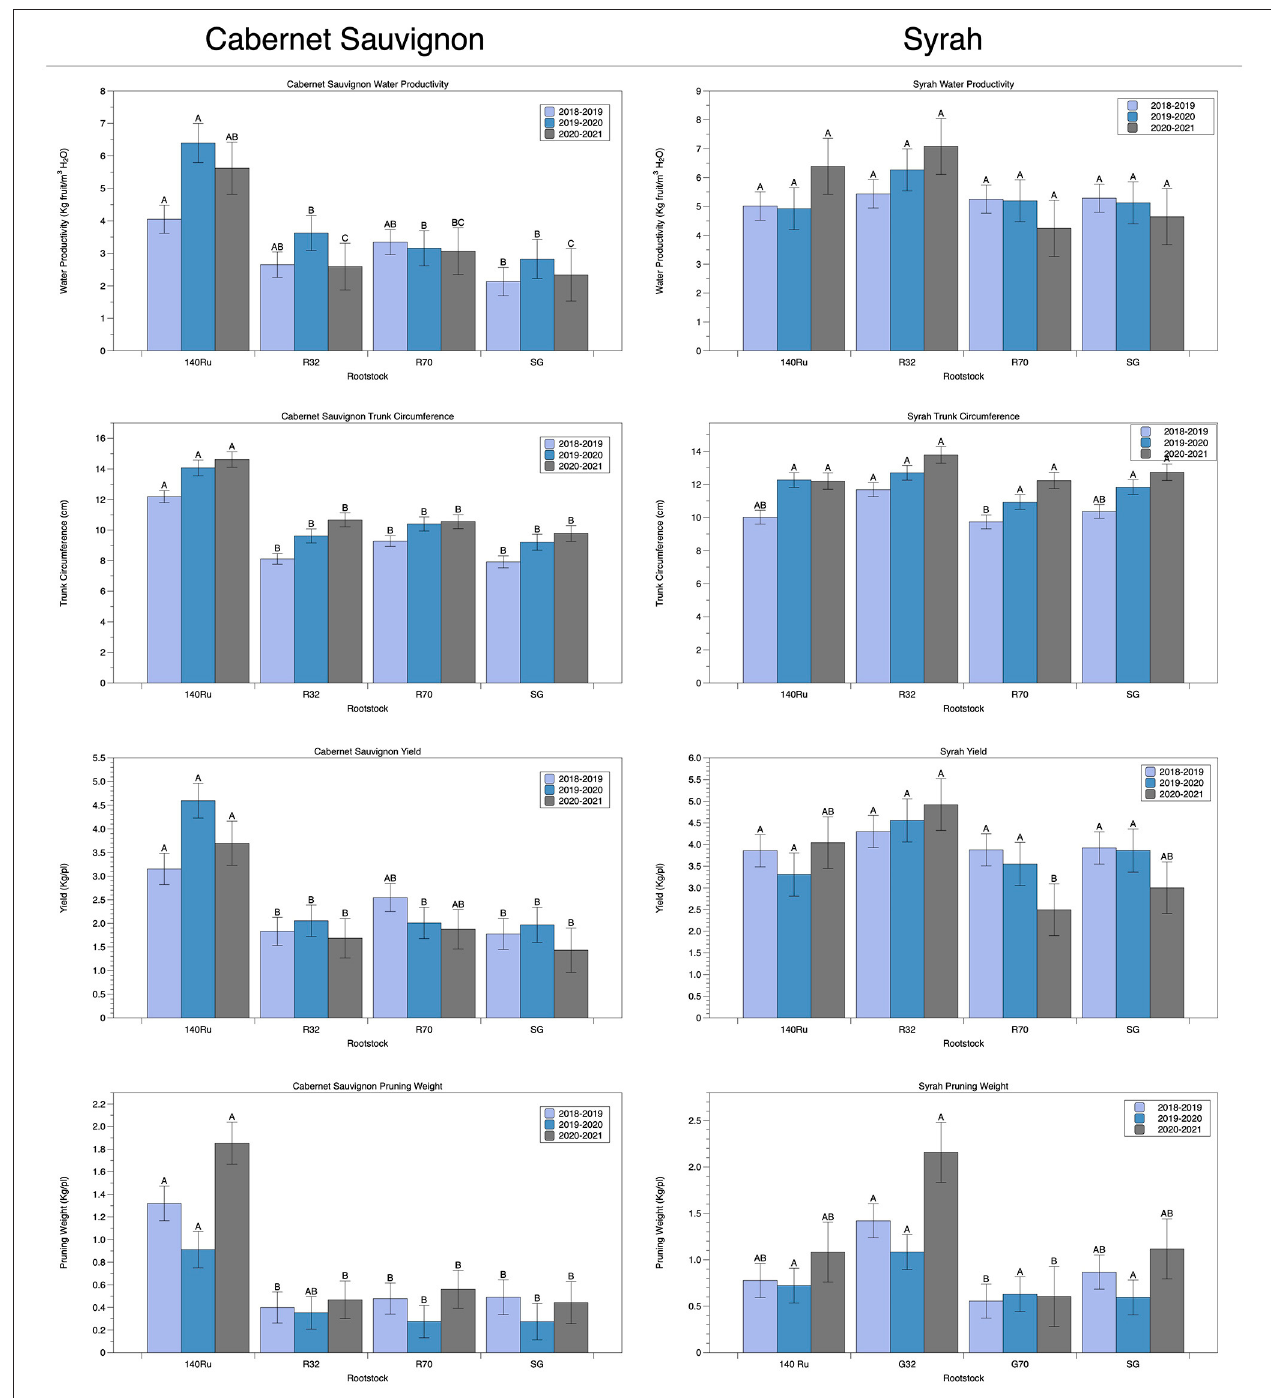
FIGURE 6 | Functional responses of selected rootstocks for productivity attributes, including Water Productivity, Trunk Circumference, Yield, and Pruning Weight among seasons and cultivars. Within each panel, different letters represent significant differences ( p -value < 0.05).